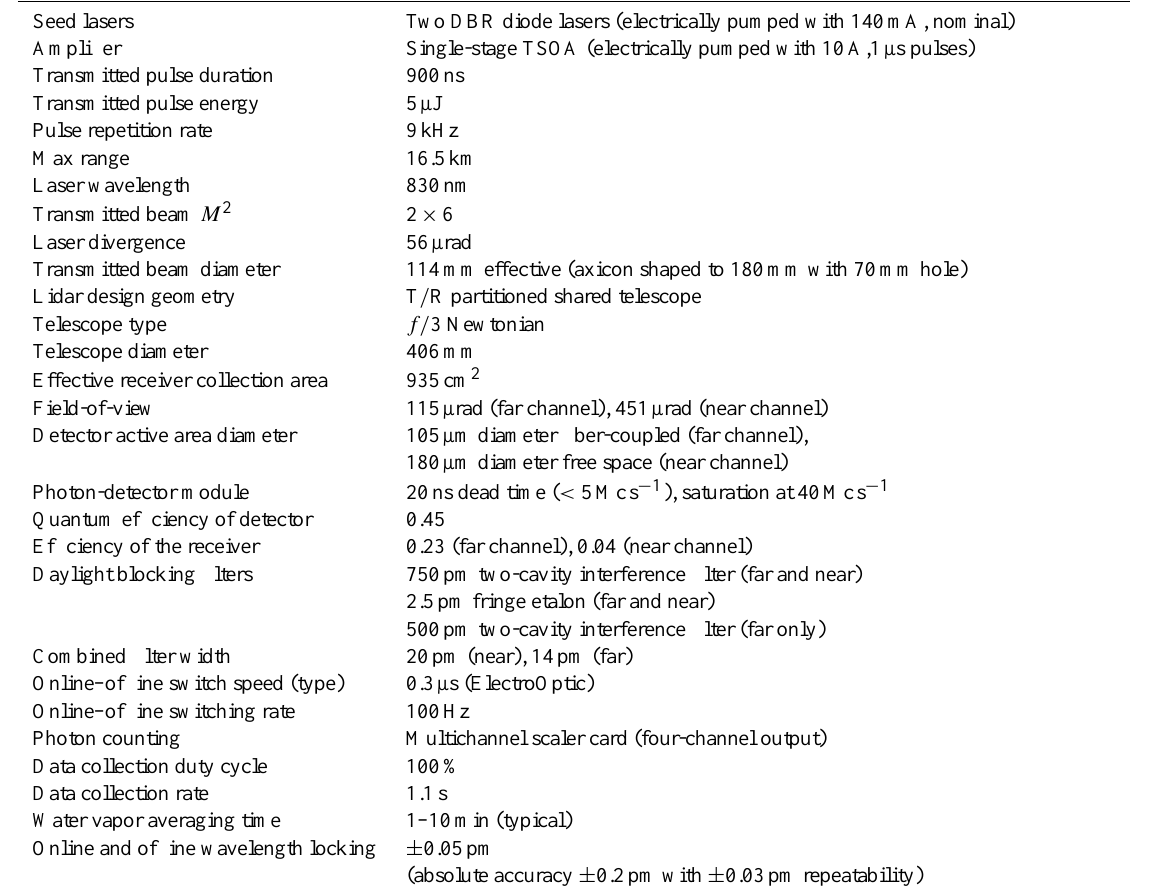
Table 1. Instrument parameter